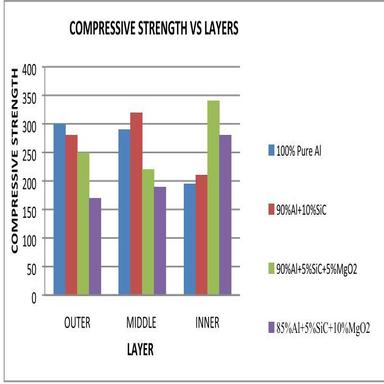
A bar chart shows the variation between the compressive strength with respect to the variation of the layers.